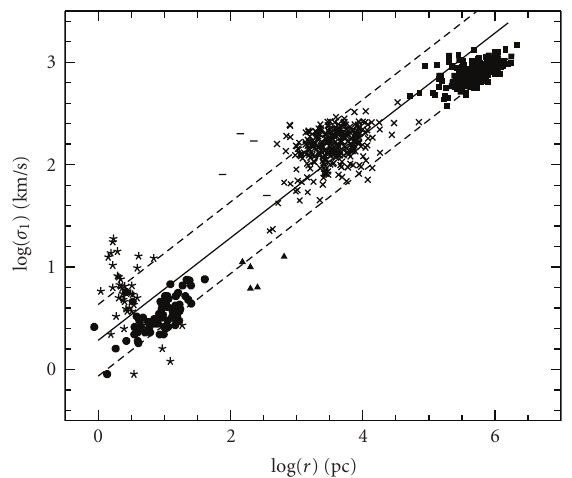
Figure 4: A log-log plot of the velocity dispersion in hot stellar systems against the characteristic size for di ff erent classes of objects. The star points are globular clusters, the solid round points are massive molecular clouds in the Galaxy, the crosses are luminous elliptical galaxies, the triangles are dwarf spheroidal galaxies, the dashes are compact dwarf ellipticals, and the squares are X-ray emitting clusters of galaxies. The solid line corresponds to σ 2 /r = a 0 and the dashed lines show a factor of 2.2 variation on each side. The references to the relevant observational papers may be found in